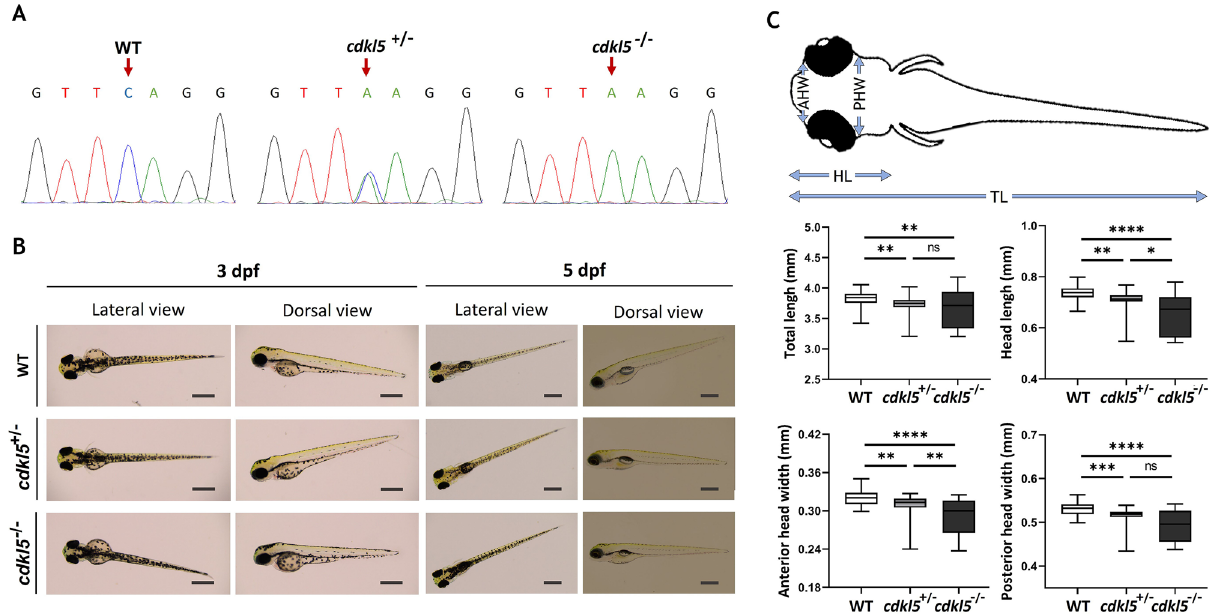
Figure 2. Characterization of cdkl5 sa21938 mutant at initial larval stages. ( A ) Sequencing chromatograms showing the zebrafish genotypes for cdkl5 . Arrows indicate the mutation site. ( B ) Representative lateral and dorsal images of wild-type (WT), heterozygous ( cdkl5 + / − ), and homozygous ( cdkl5 − / − ) mutant embryos with 3 dpf and 5 dpf. Scale bar = 0.5 mm. ( C ) Morphometric analysis of 5 dpf WT (n = 51), cdkl5 +/− (n = 50) and cdkl5 −/− (n = 71) embryos. Data are presented as median with interquartile range. Three independent experiments were performed. Statistical analysis was performed using Kruskal–Wallis followed by Dunn multiple comparisons test. *, **, ***, **** indicate p < 0.05, p < 0.01, p < 0.001 and p < 0.0001, respectively. ns indicates not significant. TL-total length; HL-head length; AHW-anterior head width; PHW-posterior head width.